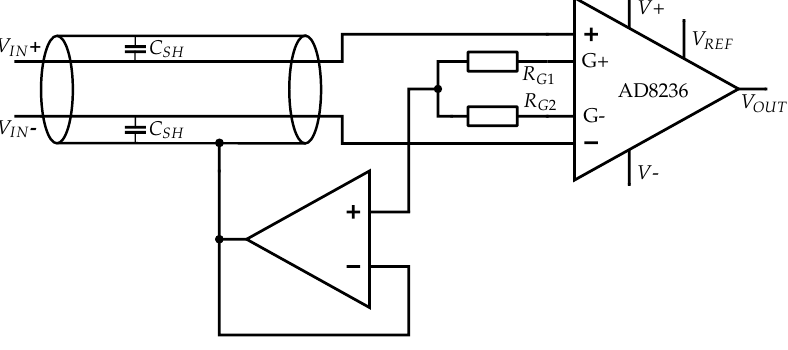
Figure 7. Common-mode shield for increasing the common-mode rejection ratio and protecting against external